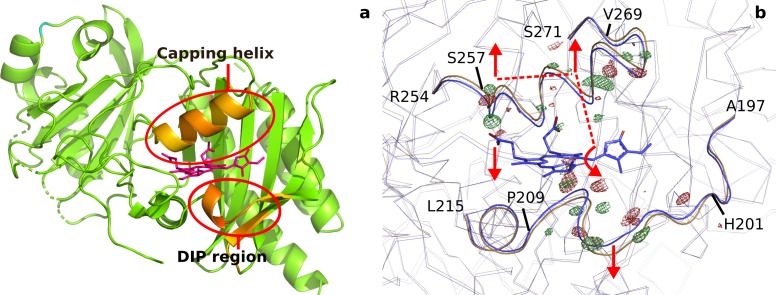
Backbone movements at 1 ps.(a). Difference (DrBphP1ps-DrBphPdark) in distances between each Cα and the pyrrole water (DrBphPdark) plotted for all differences that are larger than 0.45 Å for monomer B. Longer distances are colored red and biliverdin is shown as pink sticks. The regions that move the most, the ’DIP region’ and the ’capping helix’ above the chromophore are marked with red circles. (b). The observed difference electron densities indicate backbone movements away from the chromophore for residues 201–209 and 257–269, and an expansion of the chromopore-binding pocket. The DrBphPdark structure is colored blue and the DrBphP1ps structure is colored beige. The observed electron density map is contoured at 4.0 σ. The dashed lines indicate the proposed signal transduction pathway from D-ring to B-ring propionate.